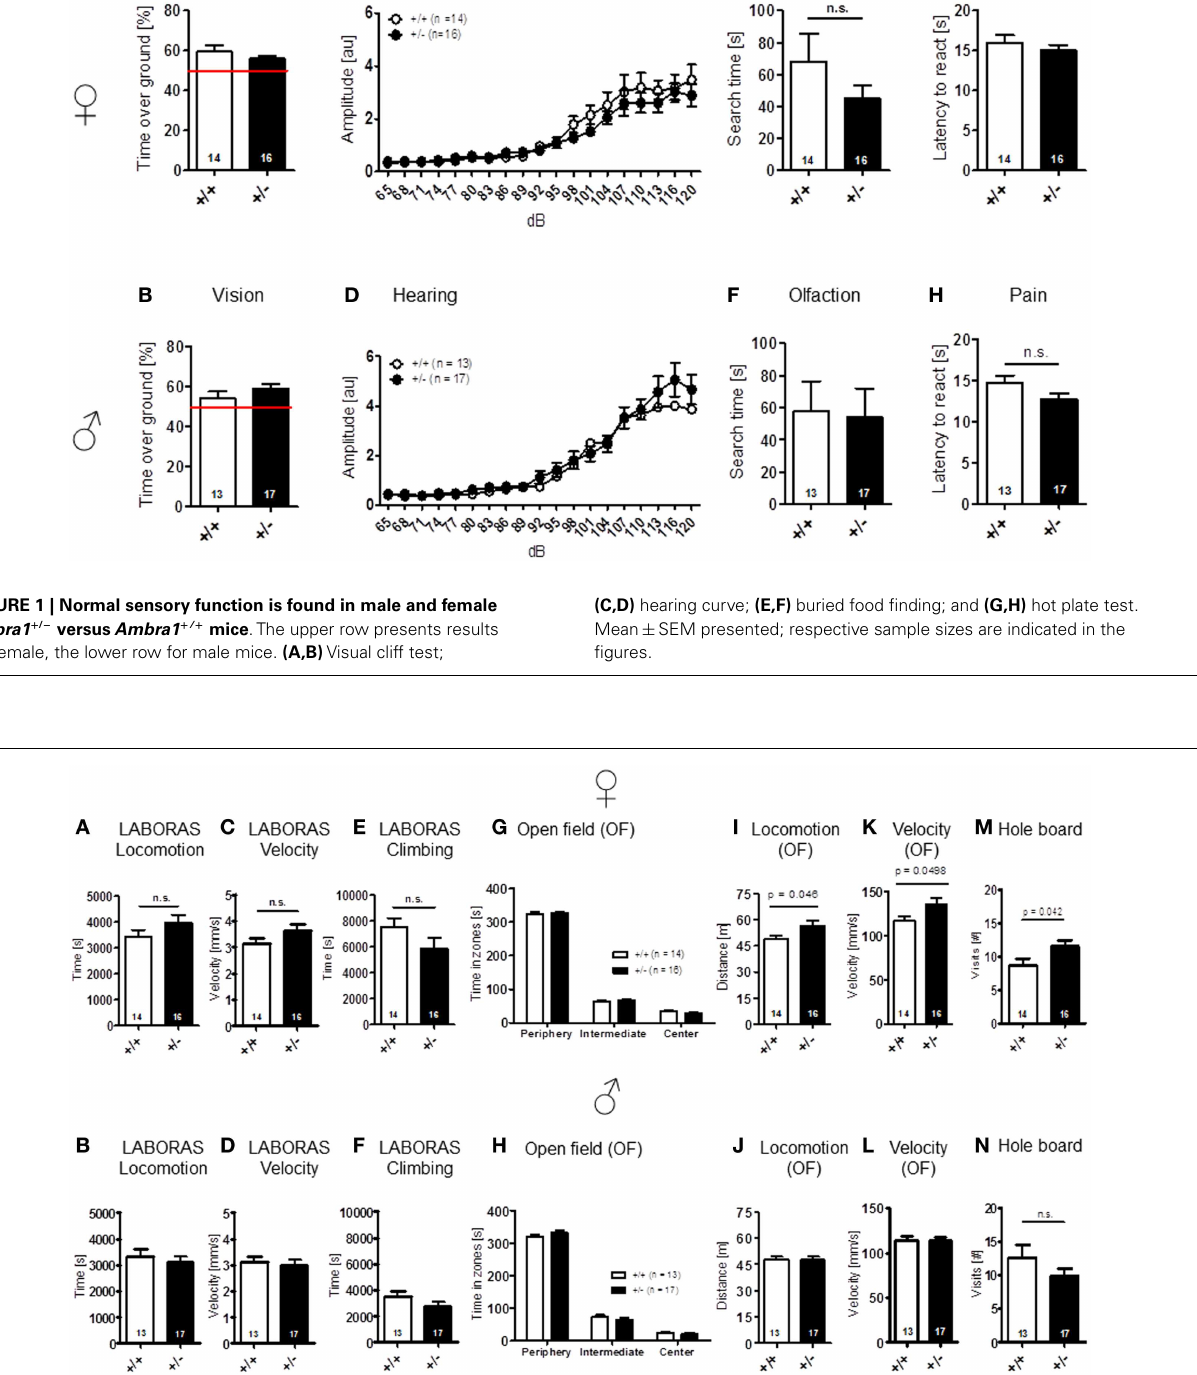
FIGURE 2 | Spontaneous and novelty-induced activity of Ambra1 + / − versus Ambra1 + / + mice are widely comparable .The upper row presents results for female, the lower row for male mice. (A–F) LABORAS standard